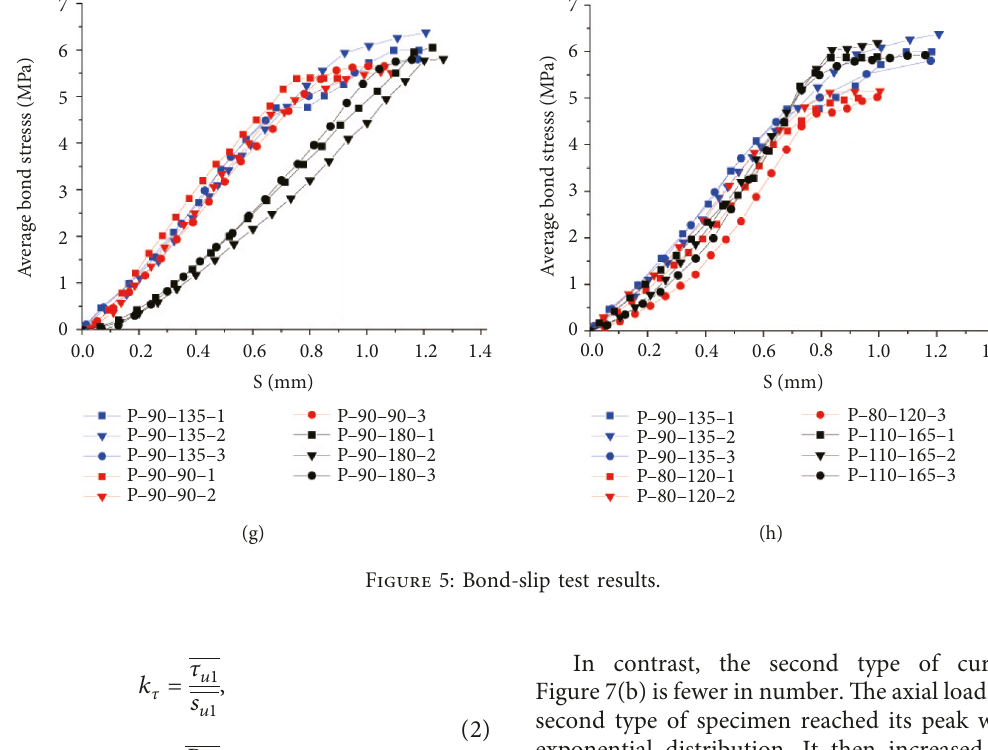
Figure 5: Bond-slip test